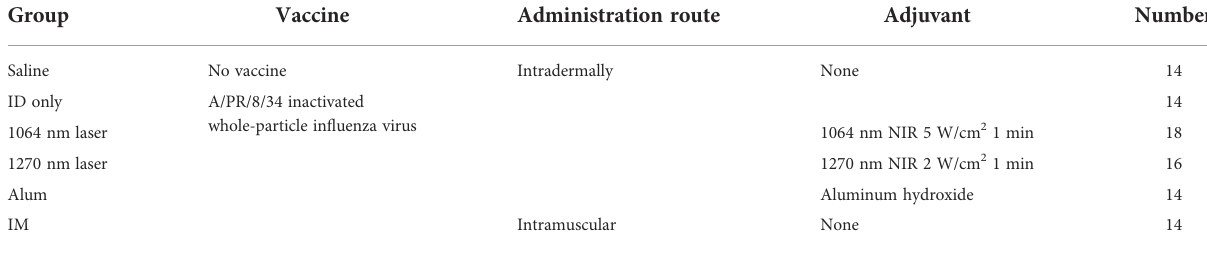
TABLE 1 Characteristics of each group in mouse in fl uenza vaccine models.